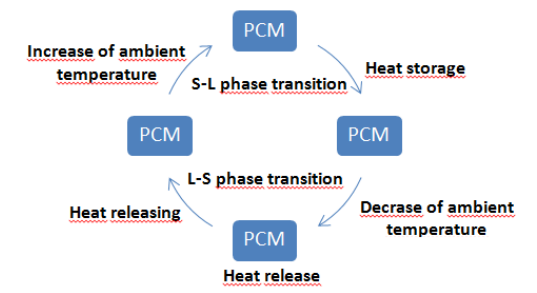
Figure 1. Solid - liquid phase change transition as an example of phase change transition cycle.